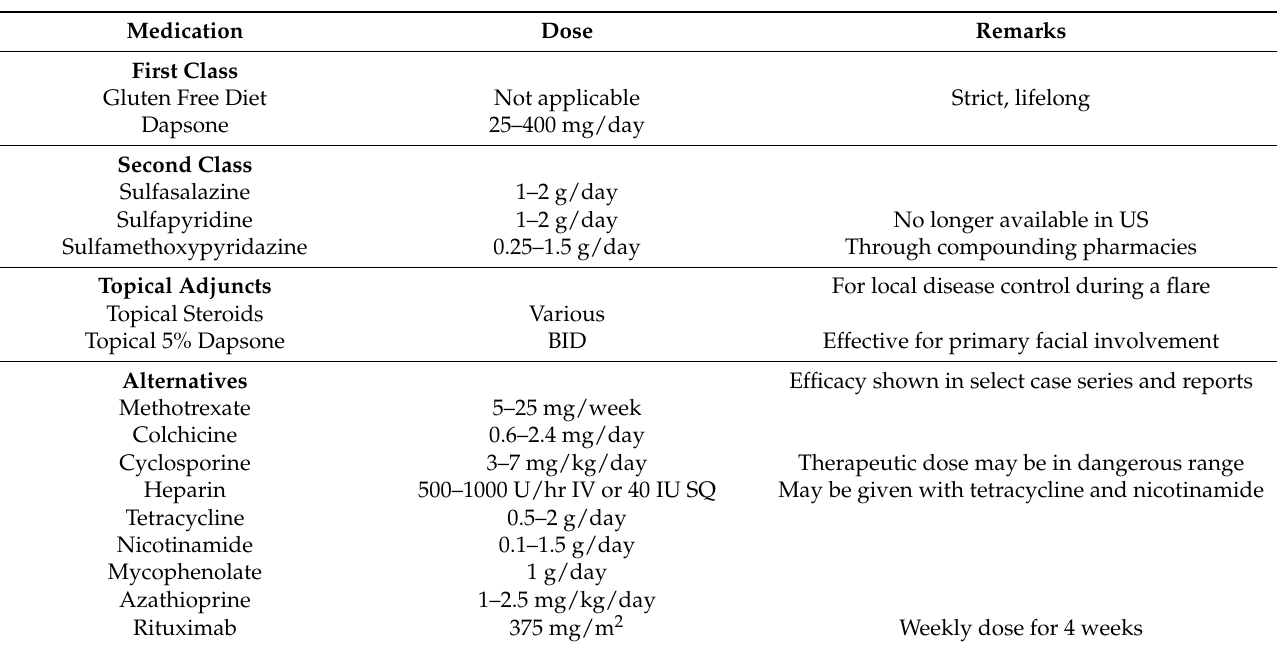
Table 1. Dermatitis herpetiformis management